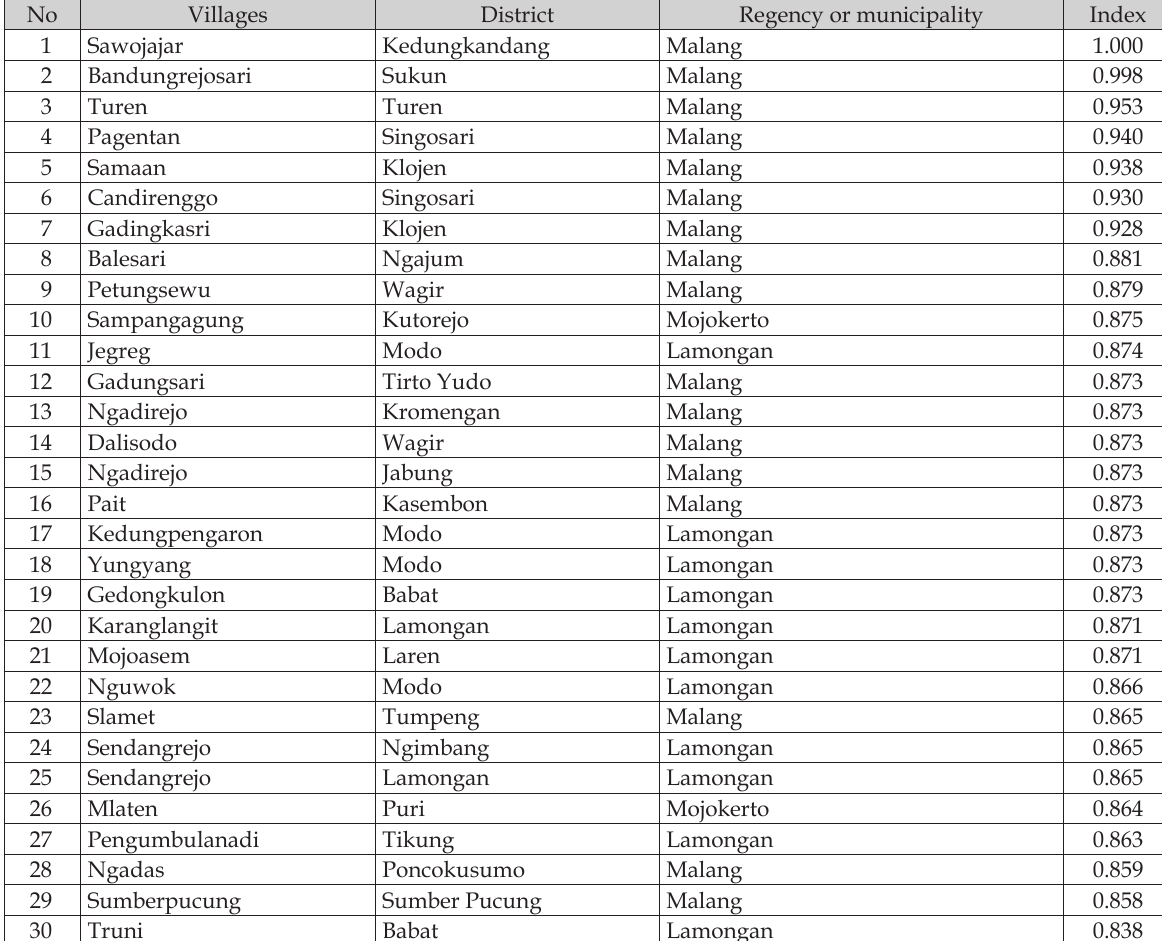
Table 9. List of villages with the high vulnerability index in Greater